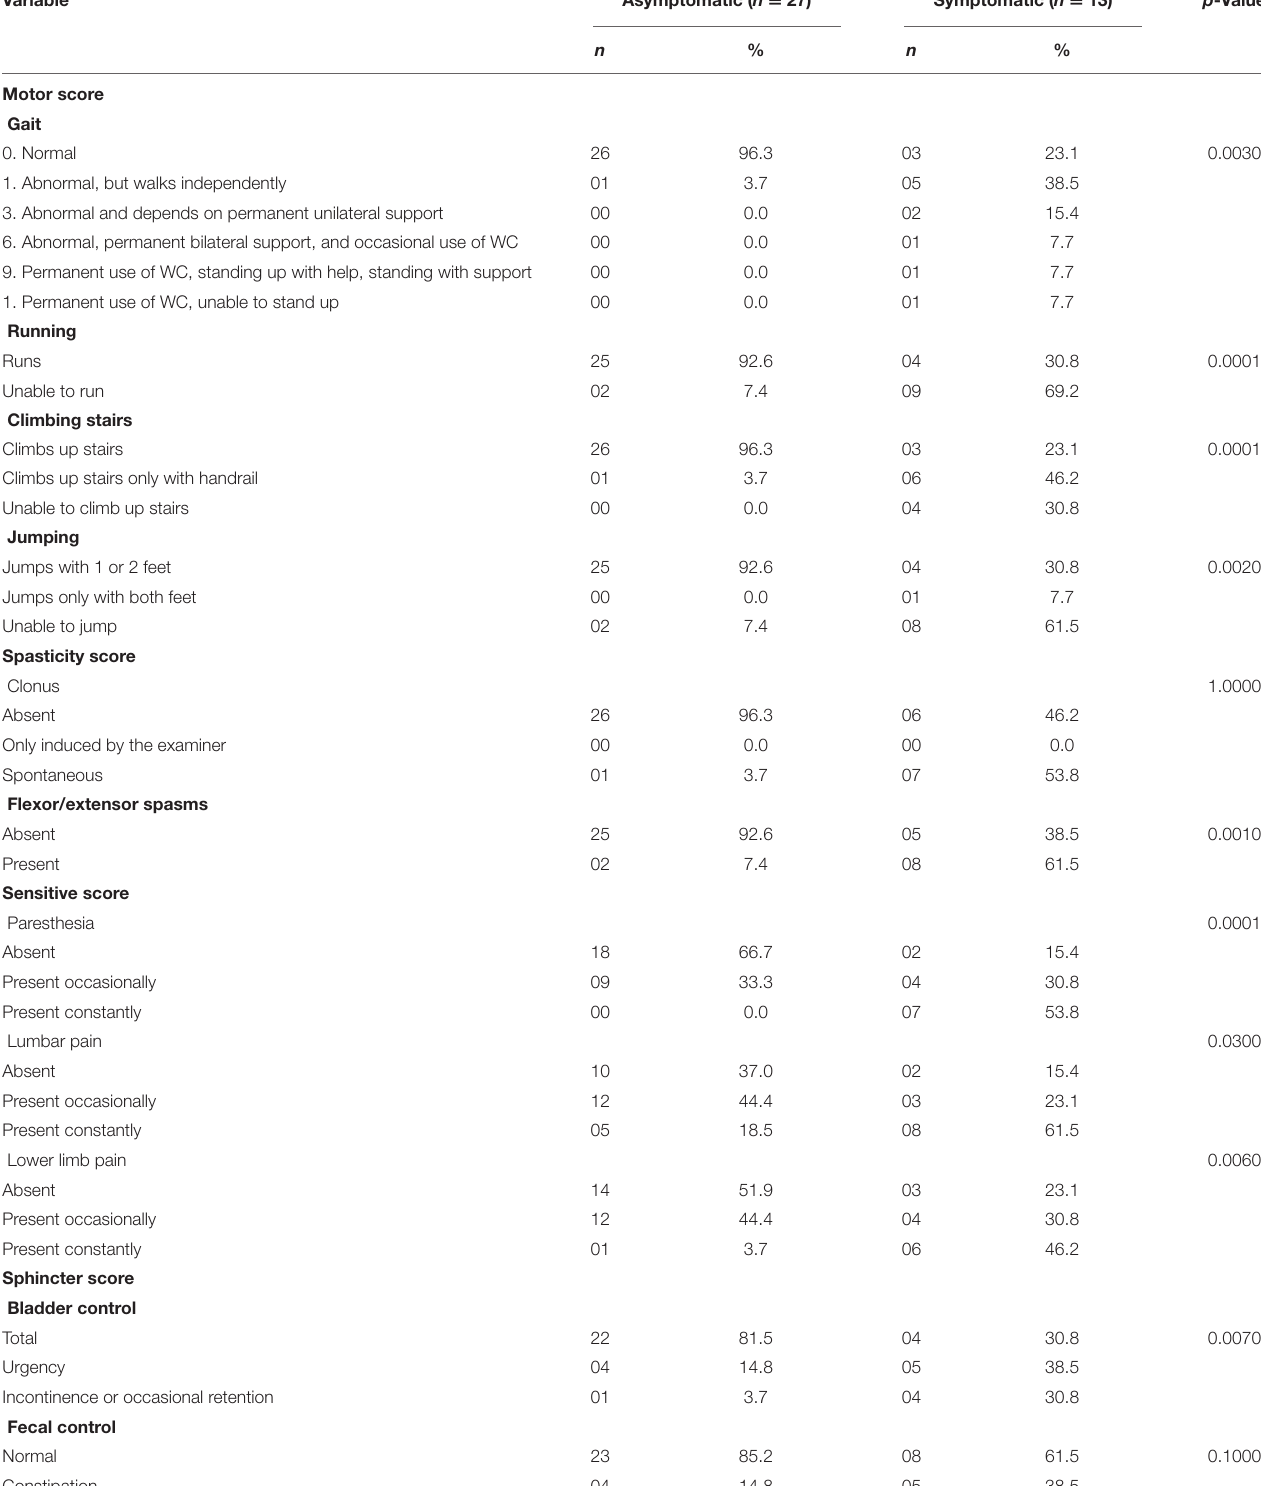
TABLE 2 | Distribution of patients infected by HTLV-1 based on clinical and functional characteristics and clinical classification.